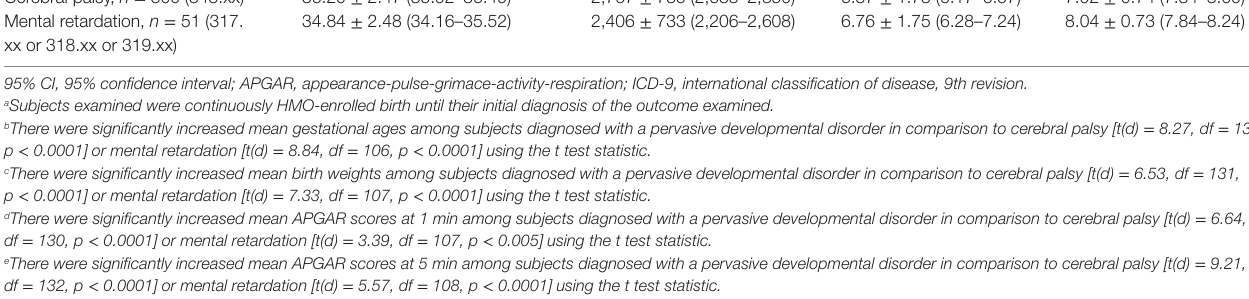
Mean aPgar at Mean aPgar at 1 min ± sD (95% ci) 5 min ± sD (95% ci)